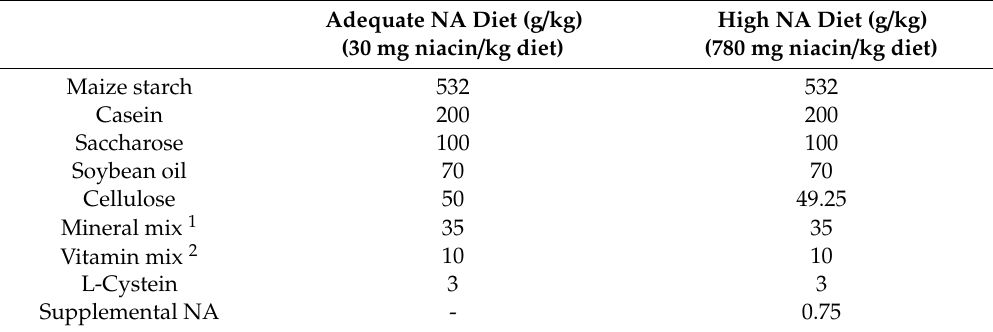
Table 1. Composition of the experimental